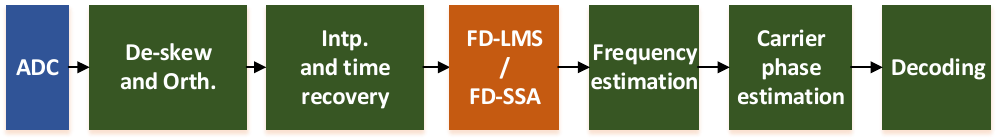
Figure 4. Full digital signal processing (DSP) stack of the single- and multi-mode DSP. Orth: orthonormalization, Intp: Interpolation.